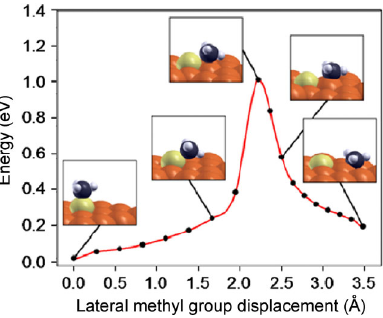
Fig. 14 Profile of calculated energy versus lateral displacement of the methyl group in methyl thiolate on a Cu(100). Also shown is the evolution in the methyl thiolate to release an adsorbed methyl group. Reproduced with permission from [128]. Copyright ACS,